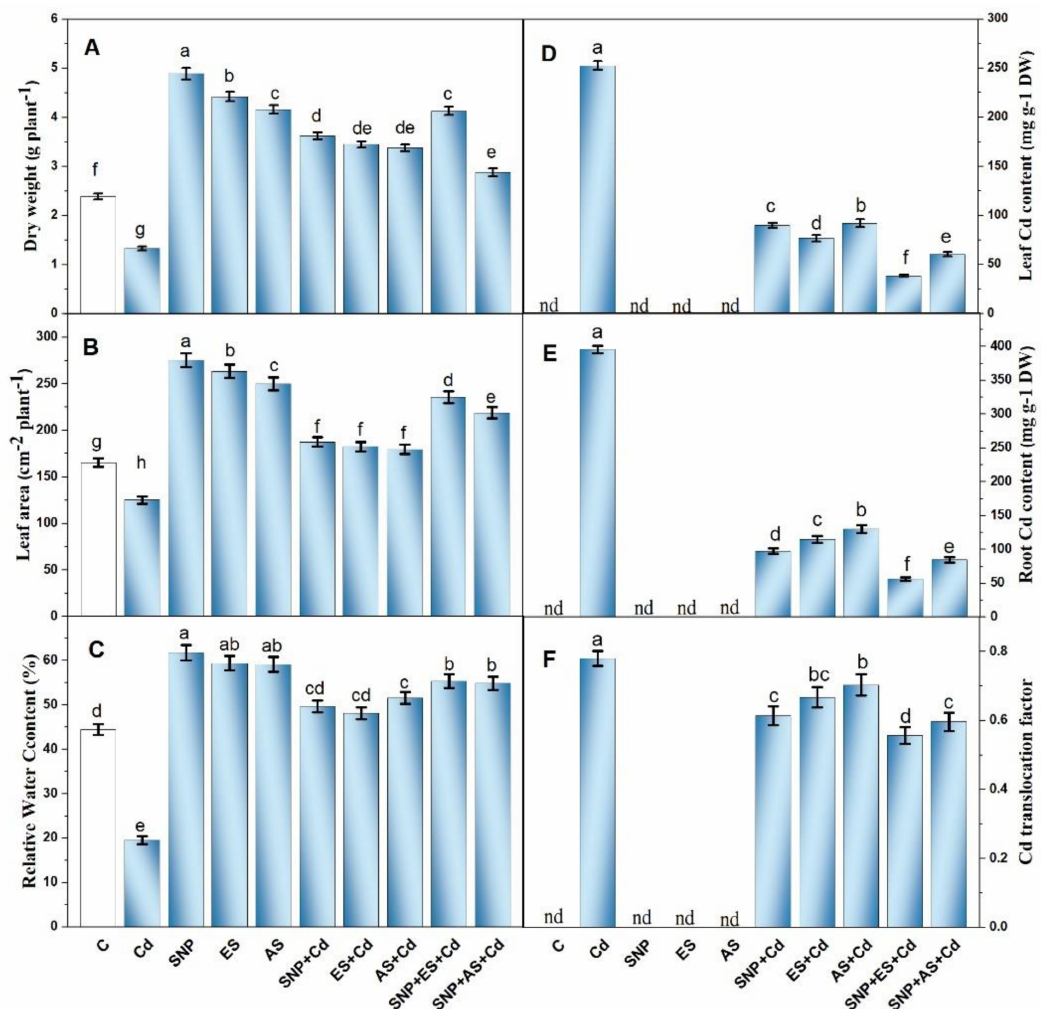
Figure 1. Plant dry weight ( A ), leaf area ( B ), relative water content ( C ), leaf Cd content ( D ), root Cd content ( E ), and Cd translocation factor ( F ) in mustard ( Brassica juncea L. cv. Giriraj) treated with 100 µ M of SNP (NO donor) and 200 mg S kg − 1 soil of elemental sulfur (ES) or ammonium sulfate (AS) in presence or absence of 200 mg Cd kg − 1 soil at 30 days after sowing. Data are presented as treatment mean ± SE ( n = 4). Data followed by the same letter are not significantly different as determined via LSD test at p < 0.05. C, control; Cd, cadmium; cv., cultivar; SNP, sodium